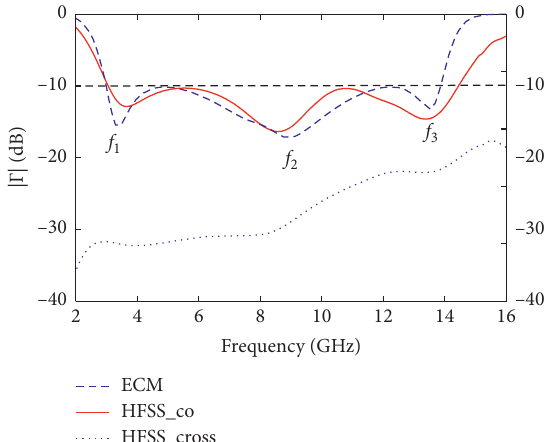
Figure 4: Simulated and calculated reflection coefficients of the proposed